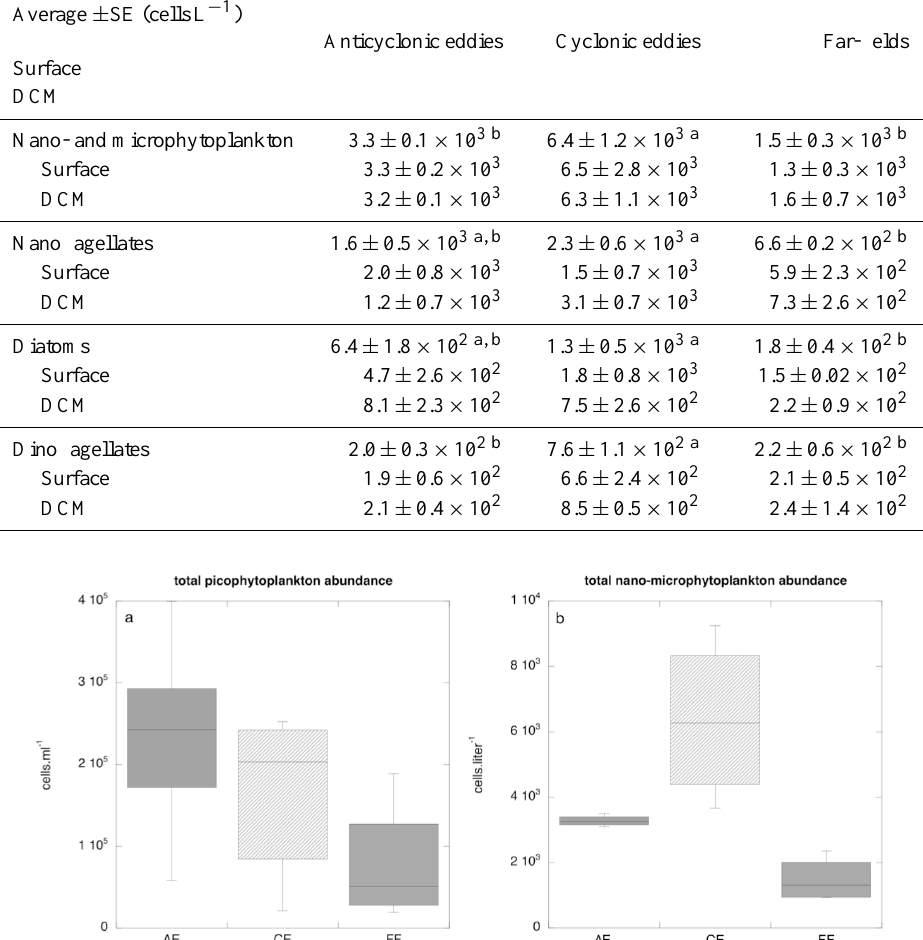
Table 3. Abundance of the microphytoplankton groups (average ±SE, from the surface and DCM) in the cyclonic and anticyclonic eddies (CE and AEs, respectively) and far-field stations studied. Average values for systems connected by different letters (a, b) are significantly different ( p < 0.05).